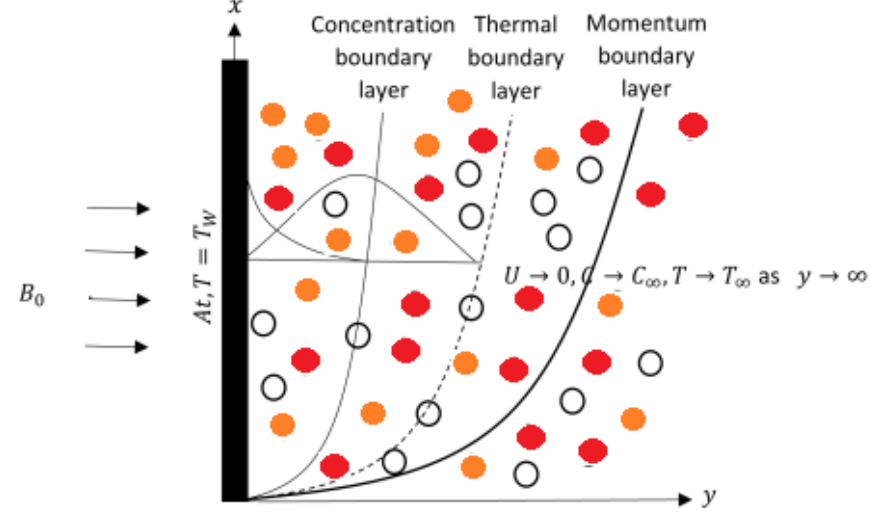
Figure 1. Physical model of the problem